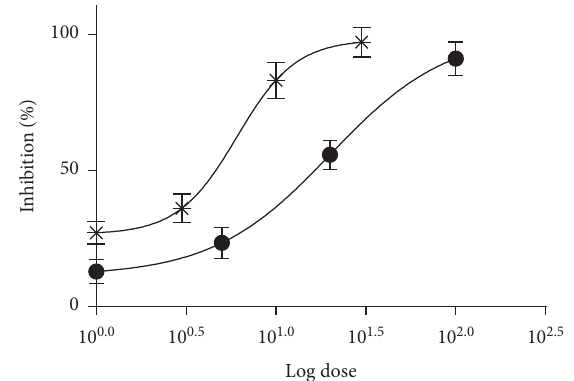
Figure 1: Dose-response curve of antimalarial activity of ( ∗ ) ART and ( • ) KMF against PbANKA-infected